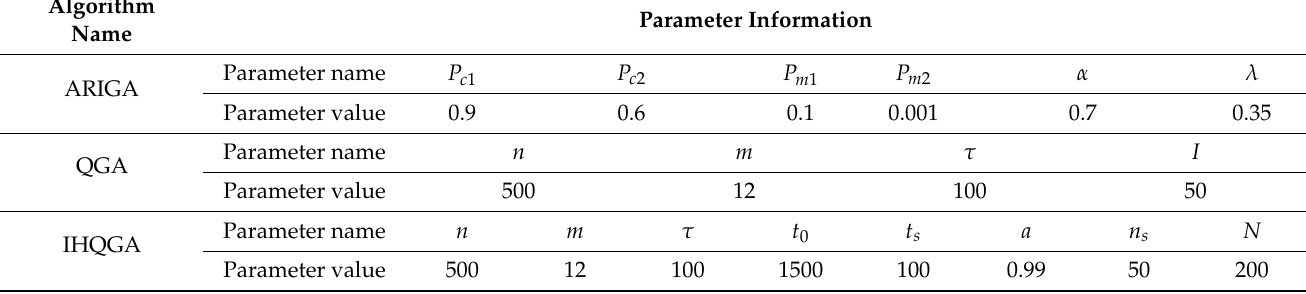
Table 7. Algorithm parameters of ARIGA, QGA, and